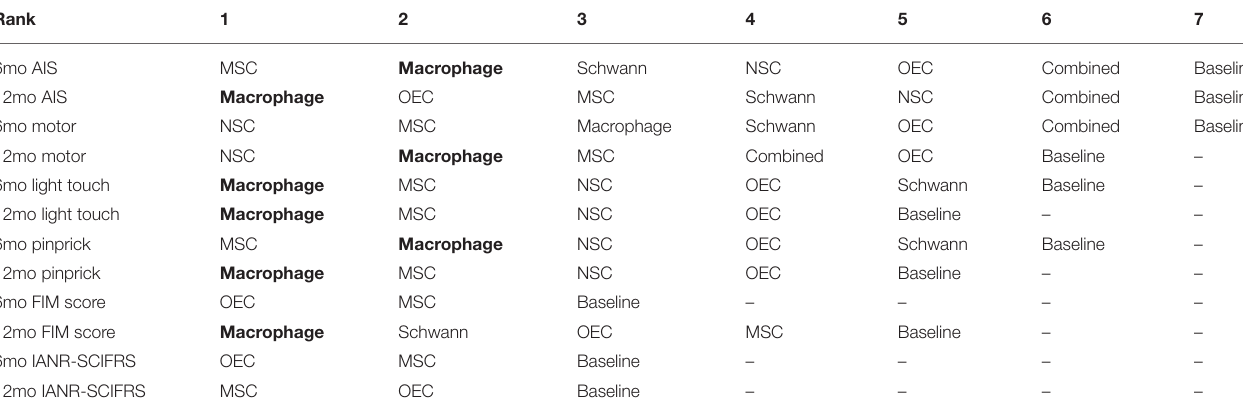
AIS, American Spinal Cord Injury Association (ASIA) Impairment Scale; FIM, functional independence measure; IANR-SCIFRS, International association of Neurorestoratology Spinal Cord Injury Functional Rating Scale; mo, month (s); MSC, mesenchymal stem cells; NSC, neural stem cell/neural progenitor cell; OEC, olfactory ensheathing cells; SUCRA, the surface under the cumulative ranking.